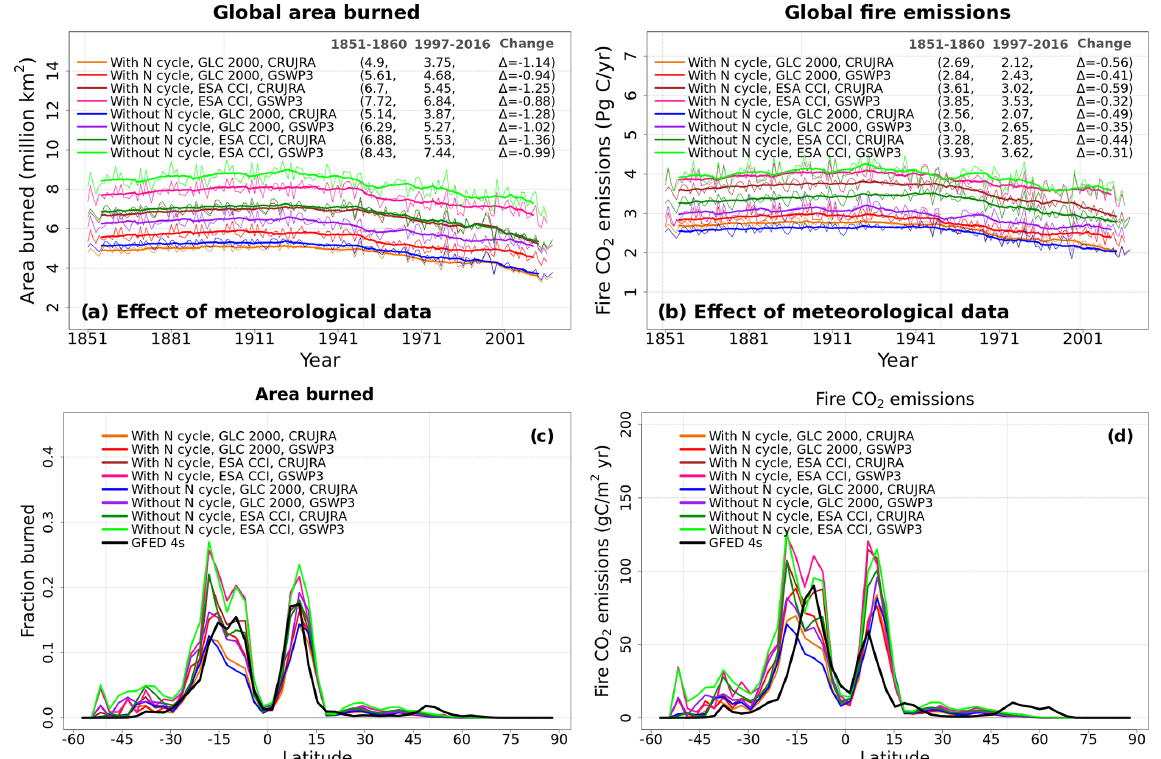
Figure A9. Time series of simulated global annual area burned (a) and fire CO 2 emissions (b) from the eight simulations summarized in Table 1; (c) and (d) show the zonally averaged area burned and fire CO 2 emissions from the eight simulations averaged over the 1997–2016 period. The thin lines for the time series show the individual years, and the thick lines show their 11-year moving average. Model values averaged over the pre-industrial (1851–1860) and present-day (1997–2016) time periods, and their difference, are also shown for (a) and (b)